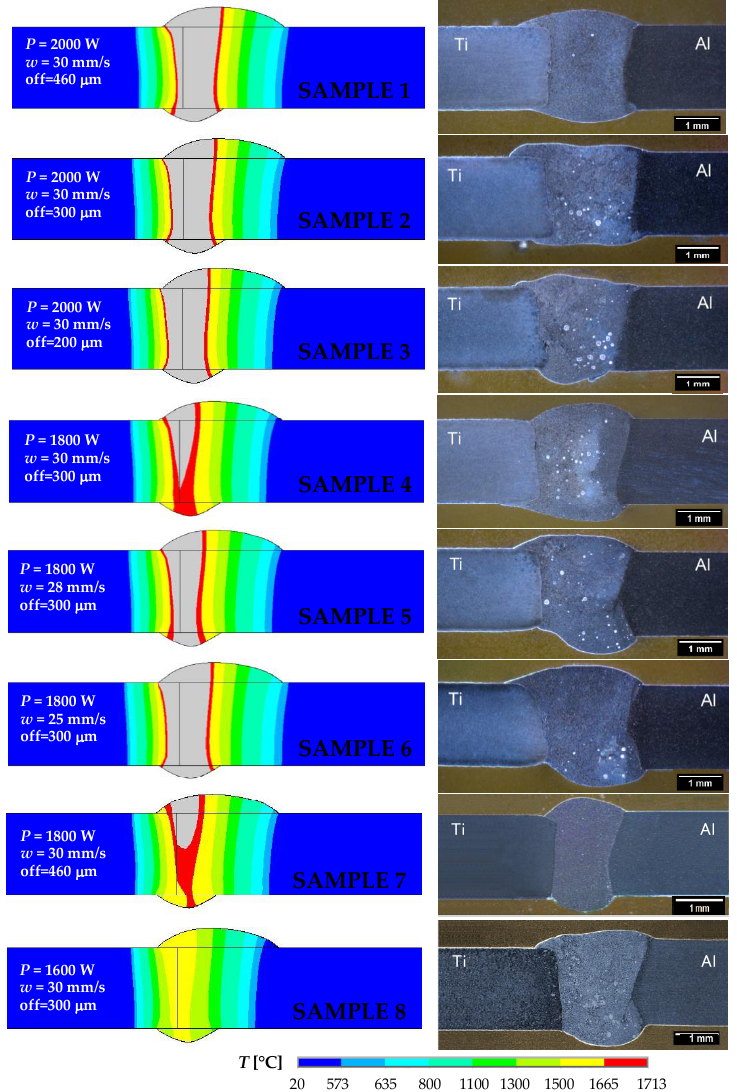
Figure 9. Comparison of the calculated temperature fields in the cross-sections perpendicular to the welding direction with the observed macrostructures of welded–brazed joints produced with various welding parameters according to Table 4.